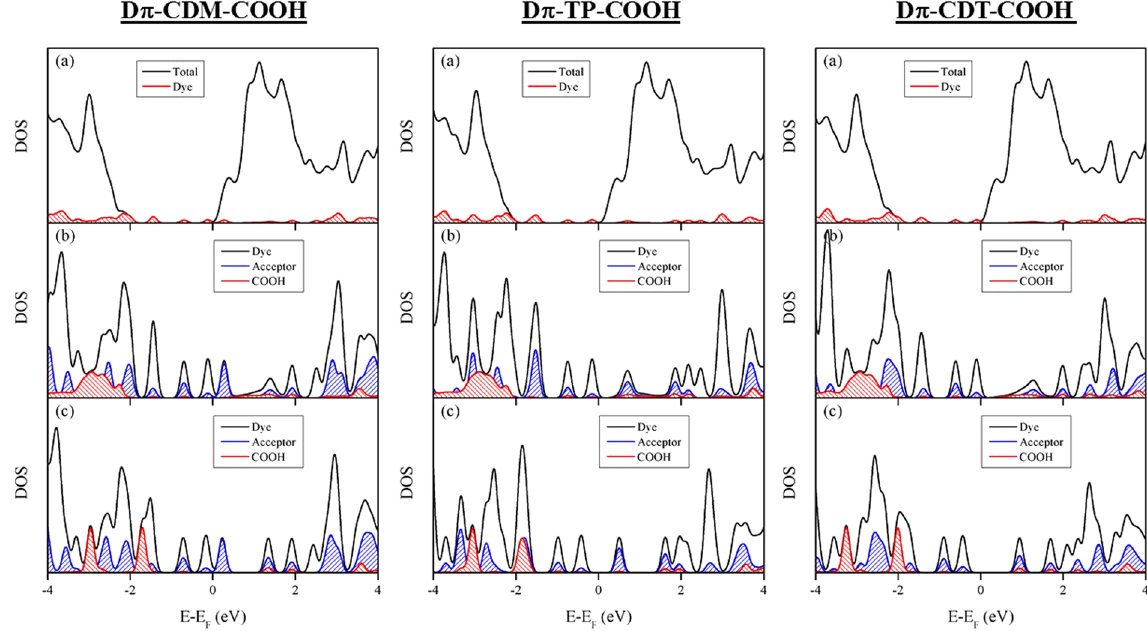
Figure 9. ( a ) Total density of states (black line) of dye with surface and that projected on dye molecules (red line), ( b ) Total density of states (black line) of dye and that projected on acceptor (Blue line) and COOH (red line) groups after the adsorption and ( c ) Total density of states (black line) of dye and that projected on acceptor (Blue line) and COOH (red line) groups before the adsorption of different acceptor substituted dyes on TiO 2 surface.